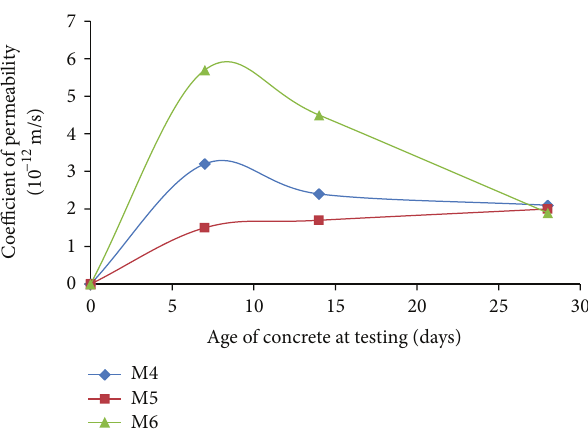
Figure 9: Effect of river sand on the cracked permeability of concrete for 400kg/m 3 of cement.